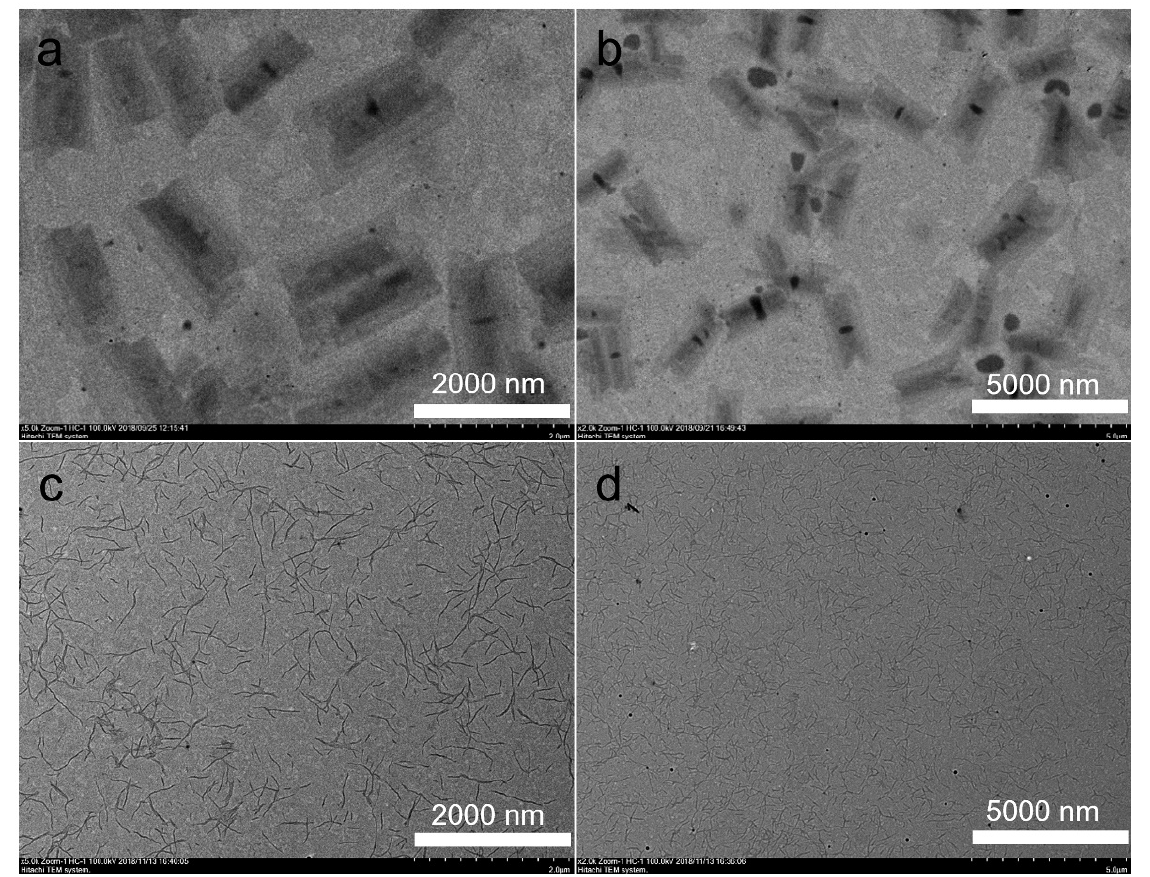
Figure 1. The TEM images of the nanostructures self-assembled by P3HT 22 - b -PEG 43 ( a , b ) and P3HT 22 - b -PEG 113 ( c , d ) in i -PrOH with the polymer concentration at c = 0.005 mg . mL − 1 .